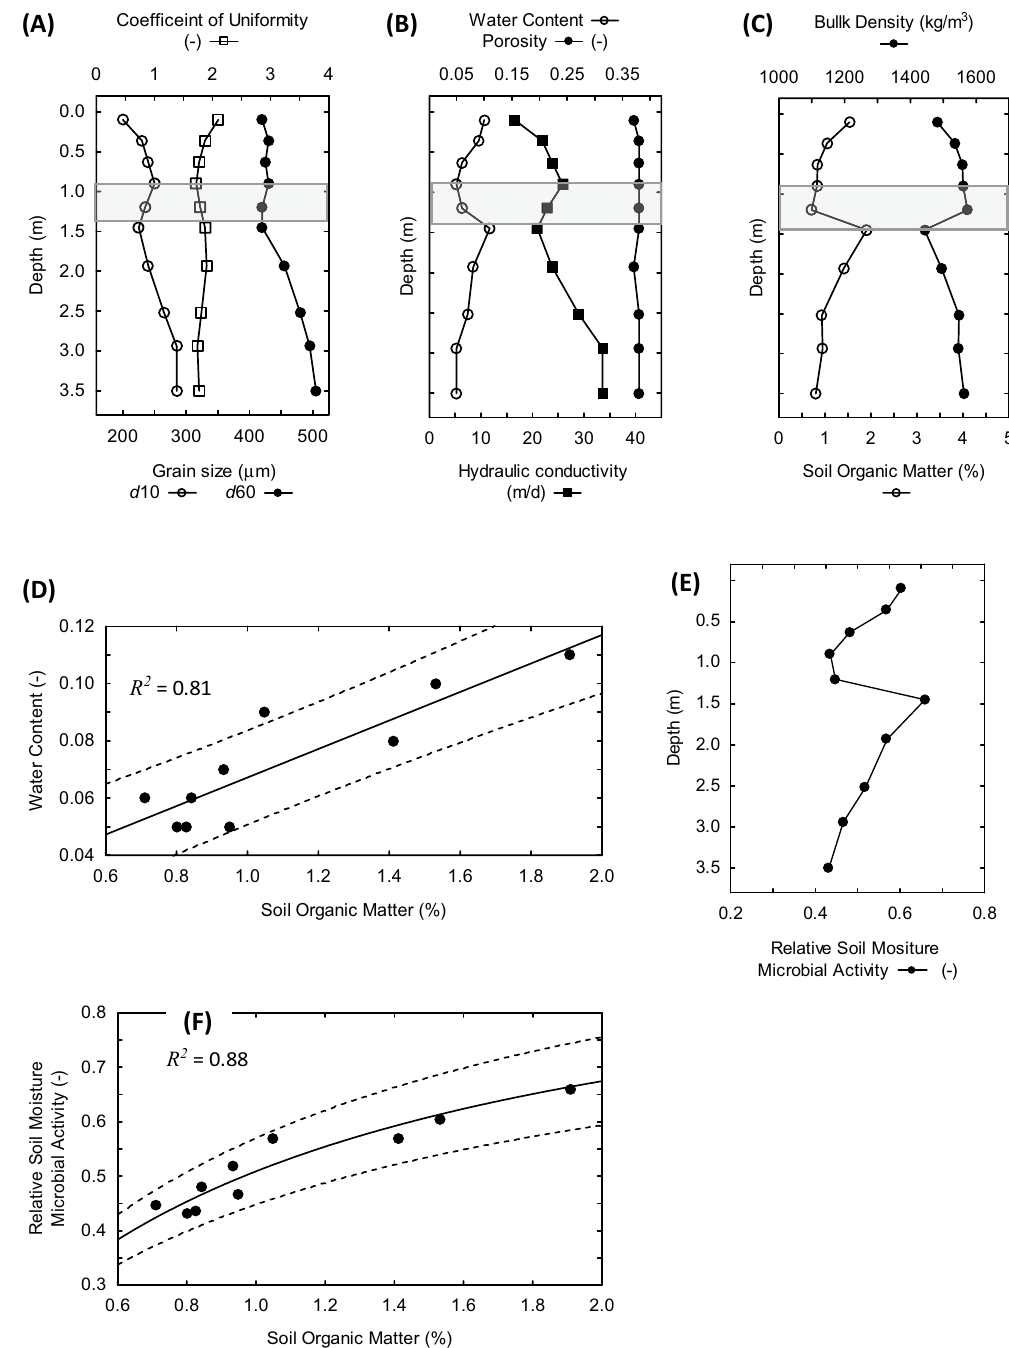
Figure 1. Soil depth profiles of hydraulic properties and relative levels of microbial metabolic activity. ( A ) Grain size distribution measurements of the tenth ( d 10 ) and sixtieth percentile ( d 60 ) particle diameters, along with the coefficient of uniformity C u = d 60 / d 10 . ( B ) Calculated saturated hydraulic conductivities and porosities, as well as measured volumetric water content. ( C ) Soil organic matter contents estimated from measured bulk densities; the shaded interval ( A )–( C ) indicates the level where overall trends in hydraulic properties undergo a short reversal. ( D ) Volumetric water content as a function of soil organic matter. ( E ) Relative levels of soil microbial activity determined with respect to volumetric water content, and jointly with respect to relative amounts of microbial biomass. ( F ) Relative soil moisture microbial activities as a function of soil organic matter. The solid line represents the best fit of the Monod kinetics model for the dependence of relative soil moisture microbial activity under limiting amounts of soil organic matter. Dashed lines are prediction intervals at p values that represent the proportion of variance accounted for by the regression ( R 2